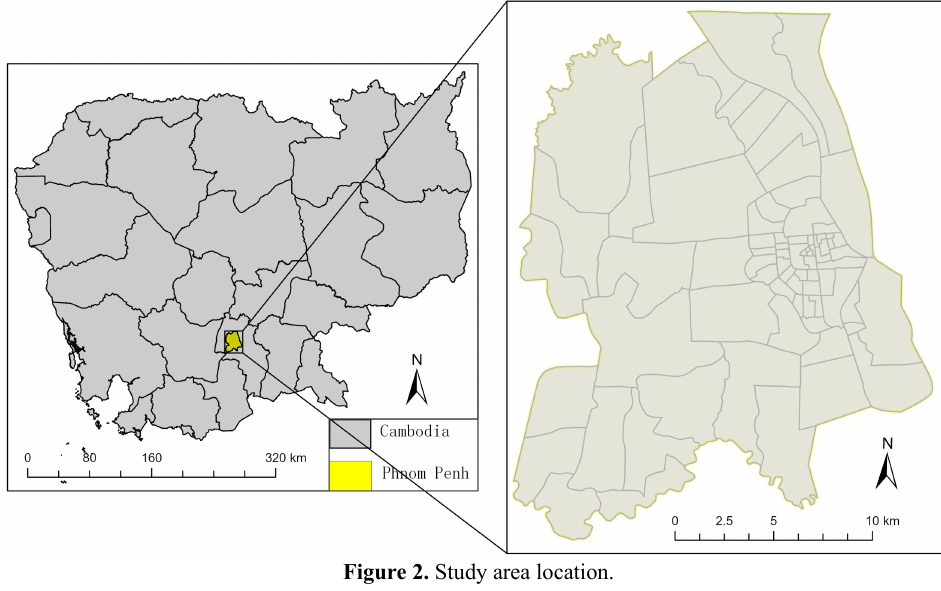
Figure 2. Study area location.